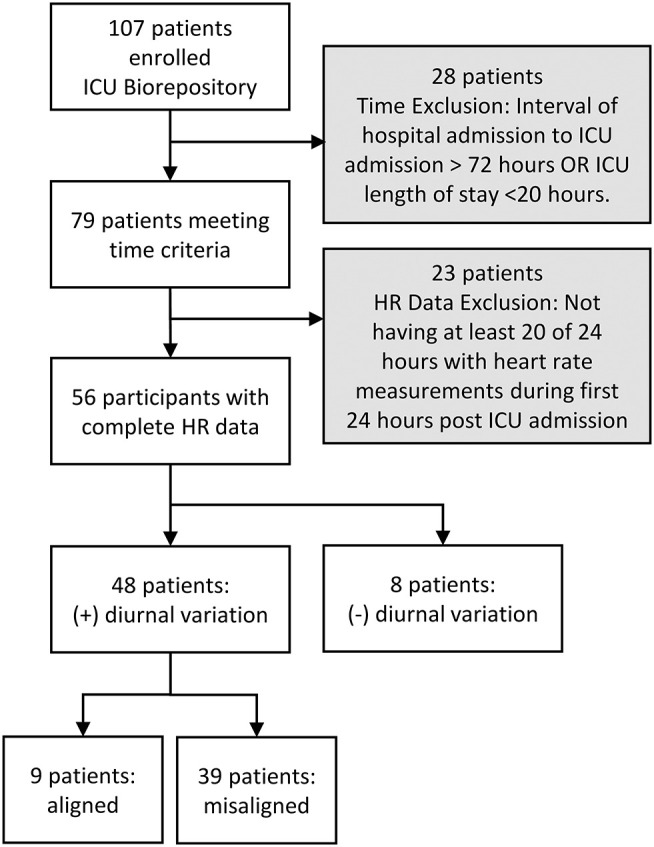
Consort diagram.